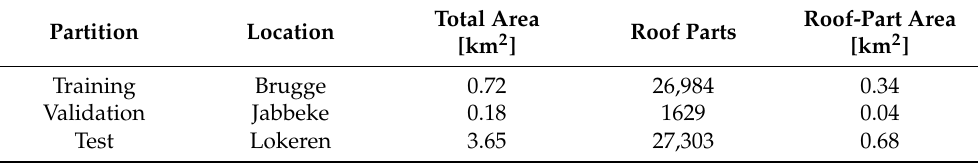
Table 1. Dataset overview.